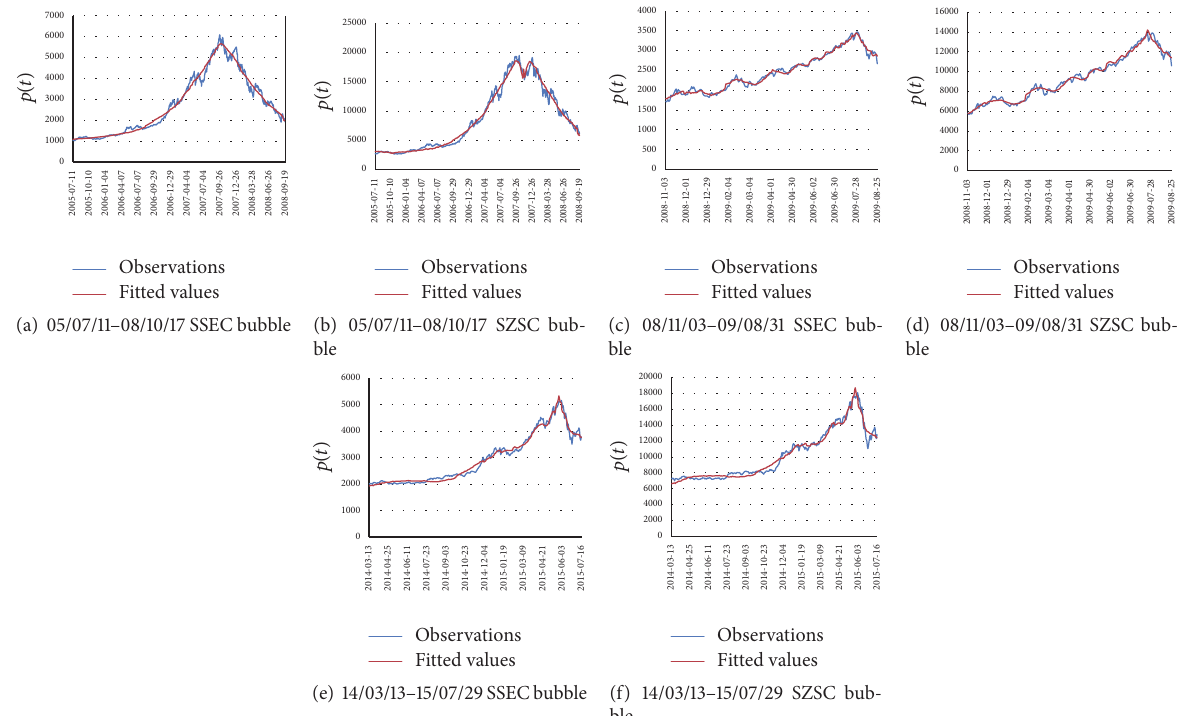
Figure 1: Daily trajectory of the SSEC and SZSC from 2005/07/11 to 2015/07/29 by using the JLS-factor model presented in (10) with 𝑦(𝑡) = 𝑝(𝑡) . The fit of SSEC from 2005/07/11 to 2008/10/17 is illustrated in (a) as a red solid line, whose parameters are 𝑡 1.89, 𝜙 = 0.03, 𝐴 = 4971.87, 𝐵 = − 4809410.22, 𝐶 = 4808854.92, 𝛼 = 215.66, 𝛽 = − 32.46, 𝜑 = − 25.11, and 𝛾 = 0.20 with an r.m.s. of the fit residuals 𝜒 = 193.04. The fit of SZSC from 2005/07/11 to 2008/10/17 is illustrated in (b) as a red solid line, whose parameters are 𝑡 𝑚 = 0.31, 𝜙 = 3.48, 𝐴 = 14926.14, 𝐵 = − 7159.59, 𝐶 = 6083.23, 𝛼 = − 320.05, 𝛽 = 92.46, 𝜑 = 39.43, and 𝛾 = 2.73 with an r.m.s. of the fit residuals 𝜒 = 643.26. The fit of SSEC from 2008/11/03 to 2009/08/31 is illustrated in (c) as a red solid line, whose parameters are 𝑡 𝑐 = 2009/08/03, 𝜔 = 17.46, 𝑚 = 0.45, 𝜙 = 2.14, 𝐴 = 3357.54, 𝐵 = − 2150.17, 𝐶 = − 122.12, 𝛼 = 74.22, 𝛽 = 37.78, 𝜑 = − 83.33, and 𝛾 = − 0.33 with an r.m.s. of the fit residuals 𝜒 = 60.49. The fit of SZSC from 2008/11/03 to 2009/08/31 is illustrated in (d) as a red solid line, whose parameters are 𝑡 𝑐 = 2009/08/03, 𝜔 = 17.28, 𝑚 = 0.53, 𝜙 = 4.80, 𝐴 = 13437.80, 𝐵 = − 10004.44, 𝐶 = 627.84, 𝛼 = 132.05, 𝛽 = 66.10, 𝜑 = − 56.60, and 𝛾 = − 0.25 with an r.m.s. of the fit residuals 𝜒 = 282.30. The fit of SSEC from 2014/03/13 to 2015/07/29 is illustrated in (e) as a red solid line, whose parameters are 𝑡 𝑐 = 2015/06/08, 𝜔 = 5.50, 𝑚 = 0.39, 𝜙 = 1.09, 𝐴 = 5884.95, 𝐵 = − 4081.11, 𝐶 = 316.83, 𝛼 = 105.11, 𝛽 = 10.50, 𝜑 = − 115.53, and 𝛾 = − 0.14 with an r.m.s. of the fit residuals 𝜒 = 119.37. The fit of SZSC from 2014/03/13 to 2015/07/29 is illustrated in (f) as a red solid line, whose parameters are 𝑡 𝑐 = 2015/06/08, 𝜔 = 5.63, 𝑚 = 0.34, 𝜙 = 3.99, 𝐴 = 13809.61, 𝐵 = − 15604.59, 𝐶 = − 1027.34, 𝛼 = − 2.62, 𝛽 = 535.60, 𝜑 = − 392.55, and 𝛾 = − 0.84 with an r.m.s. of the fit residuals 𝜒 =